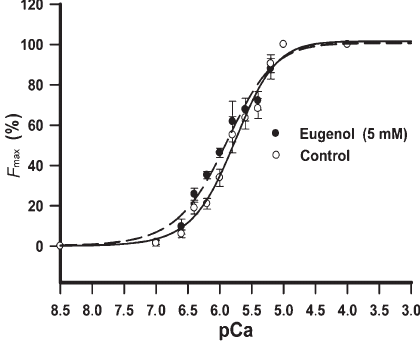
Figure 4. A , Typical chart record showing the effect of 30 mM 2,3-butanedione monoxime (BDM) on the contraction induced by 5 mM eugenol in rat atria. B , Data are reported as means±SE of the effect of eugenol and eugenol plus BDM. A significant difference in resting tension was observed (P , 0.05, eugenol vs eugenol++BDM, Student t -test; n=6).